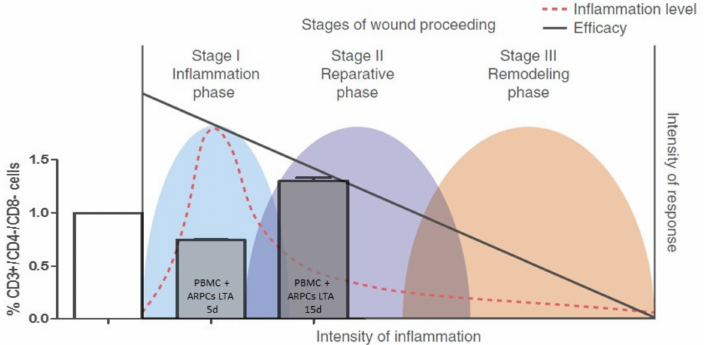
Figure 8. ARPCs can mediate immunomodulation and affect inflammatory state. “The physiological response to tissue damage can be divided into three phases: inflammatory, reparative, and re- modeling. During this process, inflammatory status (defined as the types and concentrations of cytokines and cells of the immune system present) changes considerably: proinflammatory influences (red dashed line) are dominant in the inflammatory, infection-fighting phase and diminish in the reparative and remodeling phases that follow, which allows wound healing. In the context of the intensity of the immune response (right vertical axis), the inflammatory response (red dashed line) fluctuates during the wound-healing process. Such changes in inflammation substantially alter the effects of mesenchymal stem cells (MSC)-meditated immunomodulation, which results in a variable correlation between the intensity of inflammation and efficacy of MSC treatment (solid black line)”. Such changes in inflammation are also affected by ARPC-meditated immunomodulation. ARPCs cause DN T cell decrease at the initial phase, promoting inflammation, and DN T cell increase in the late inflammation stages, favoring the inflammation quenching. Adapted by permission